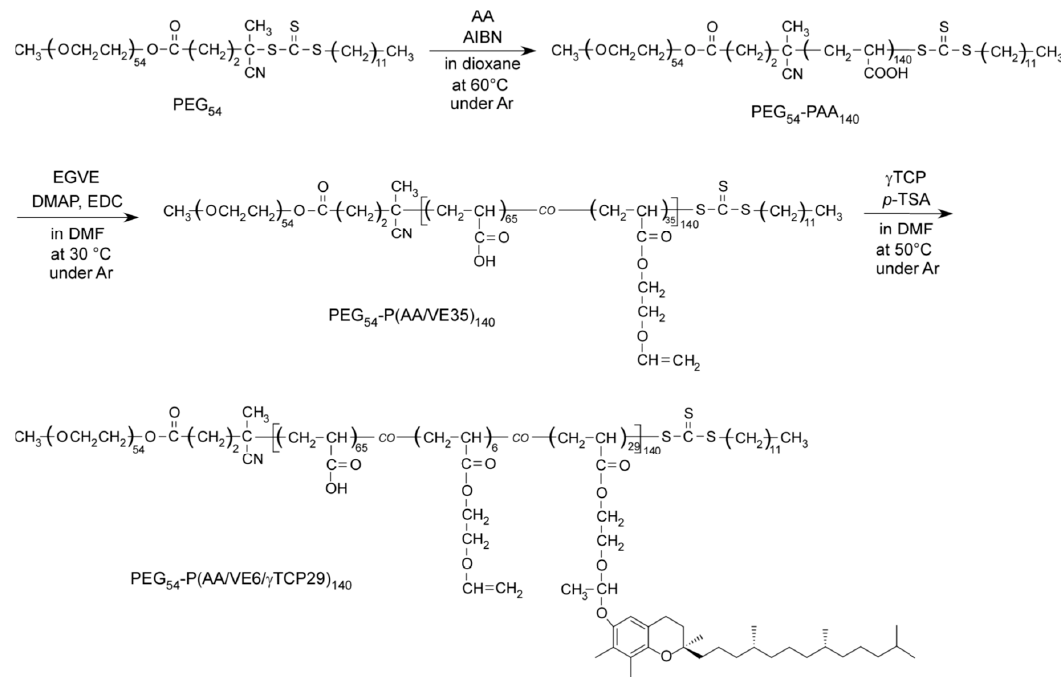
Figure 1. Synthesis of PEG 54 -PAA 140 , PEG 54 -P(AA / VE35) 140 , and PEG 54 -P(AA / VE6 / γ TCP29) 140 .